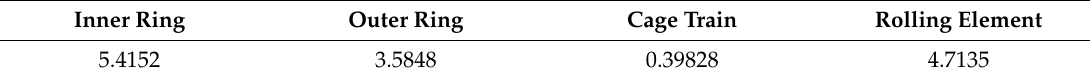
Table 1. Coefficient of drive end bearing: 6205-2RS JEM SKF, deep groove ball bearing. Inner Ring Outer Ring Cage Train Rolling Element 5.4152